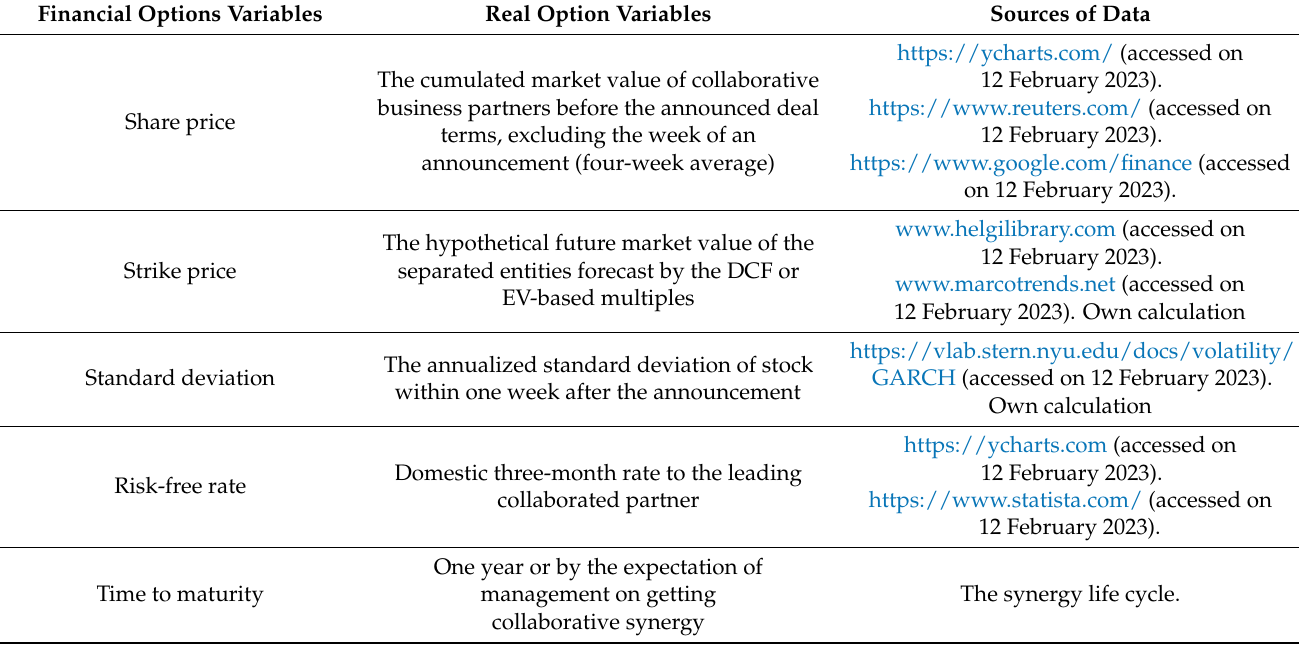
Table 1. The correspondence between financial options and real